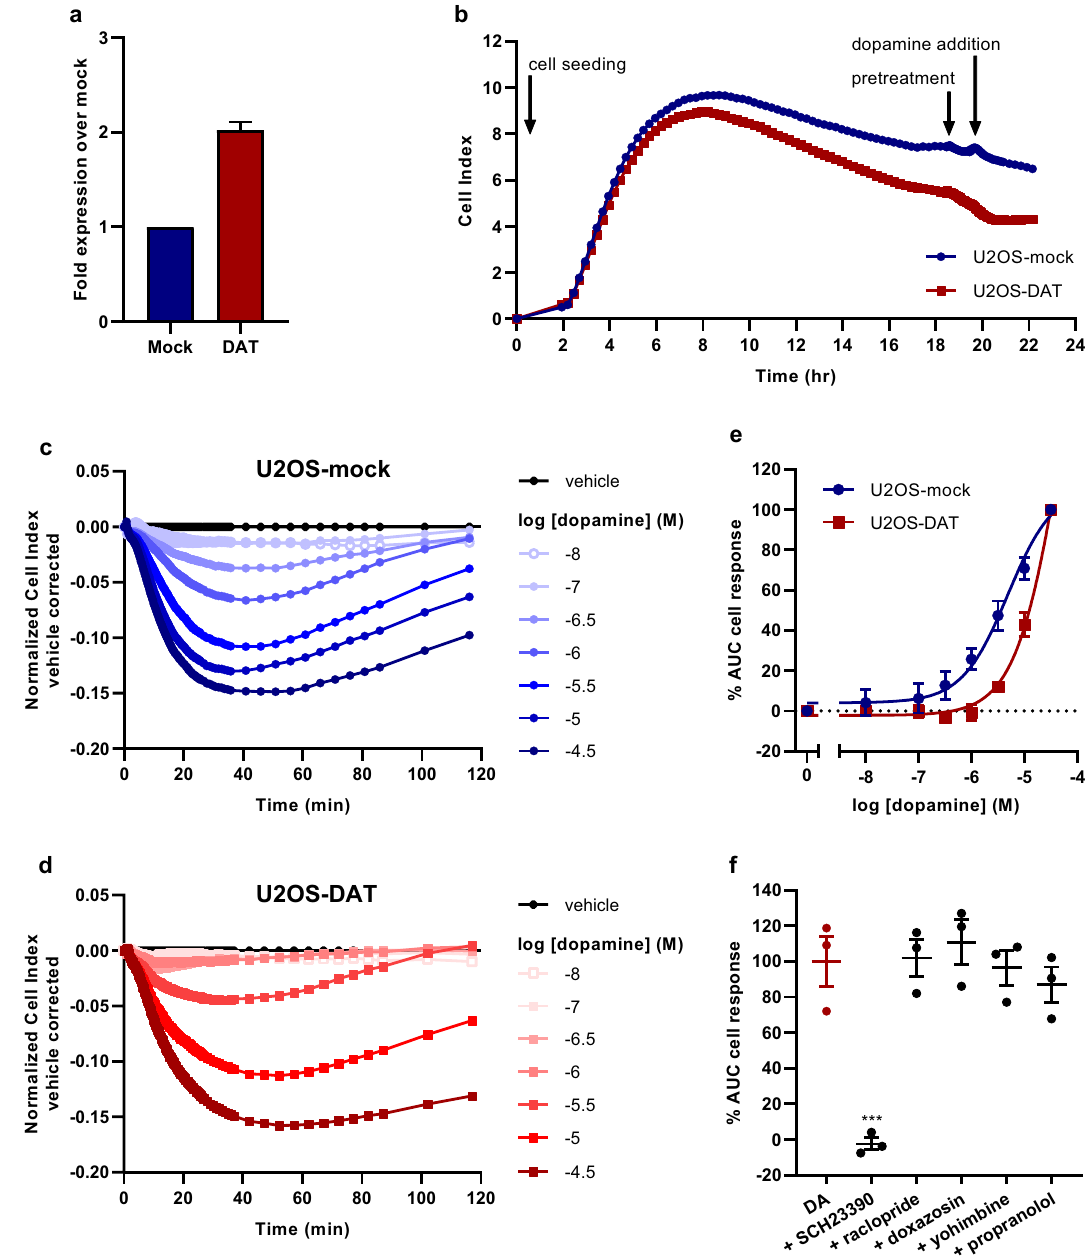
Figure 1. Functional characterization of dopamine (DA) response in U2OS-mock and U2OS-DAT cells in a TRACT assay. ( a ) FLAG-tag ELISA shows detection of C-terminal FLAG-tag of DAT, represented as mean ± SD of two separate experiments each performed in quintuplicate. ( b ) Representative xCELLigence growth curves after cell seeding, antagonist pretreatment and dopamine addition. ( c ) Representative vehicle- corrected xCELLigence traces of U2OS-mock and ( d ) U2OS-DAT cells after stimulation with increasing concentrations of dopamine. Data is normalized prior to agonist addition at time = 0 min. ( e ) Concentration- effect curves of dopamine on U2OS-mock and U2OS-DAT cells are shown as the net AUC of the first 120 min after stimulation normalized to the cell response of 31.6 µM dopamine. ( f ) Cell response of 10 µM dopamine (red bar, set at 100%) on U2OS-DAT cells pretreated for 1 h with 1 µM of one of following GPCR antagonists: SCH23390 (dopamine D 1 -like), raclopride (dopamine D 2 -like), doxazosin (alpha-1 adrenergic), yohimbine (alpha-2 adrenergic), propranolol (beta adrenergic). Data are shown as mean ± SEM of three to six individual experiments each performed in duplicate. Comparison of multiple mean values to vehicle control was done using a one-way ANOVA with Dunnett’s post-hoc test. *** p <